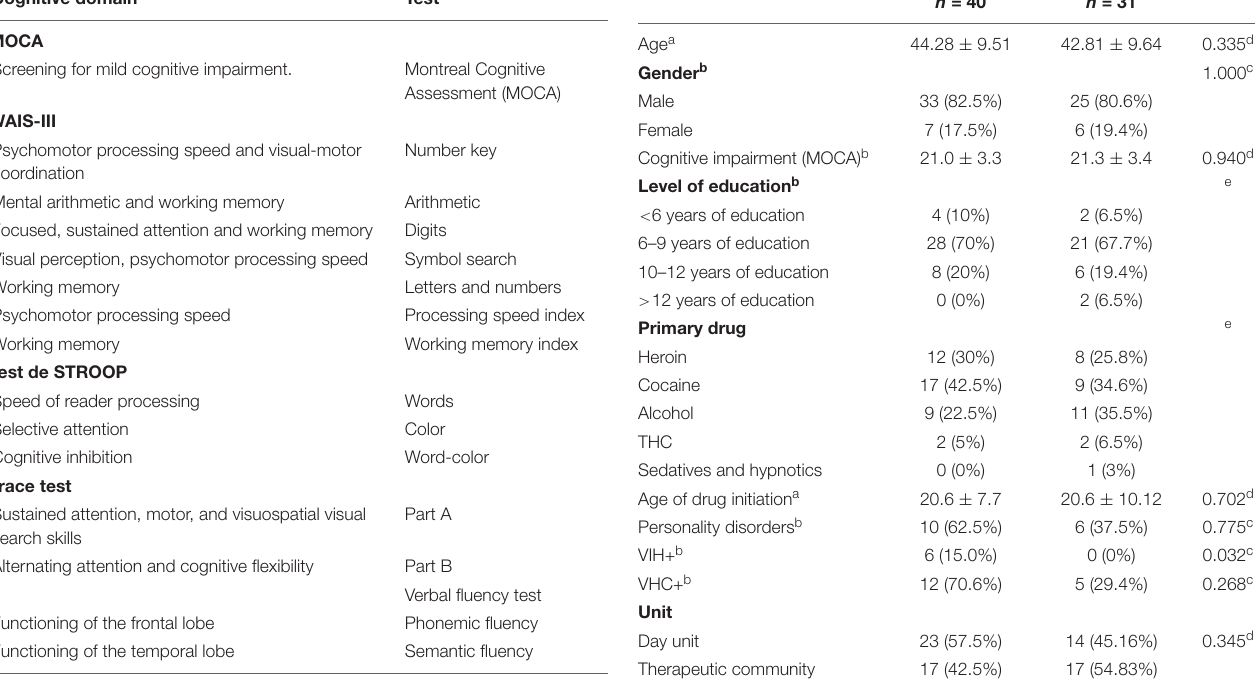
TABLE 1 | Tests selected to build a battery of neurological tests and cognitive domains assessed. Cognitive domain Test